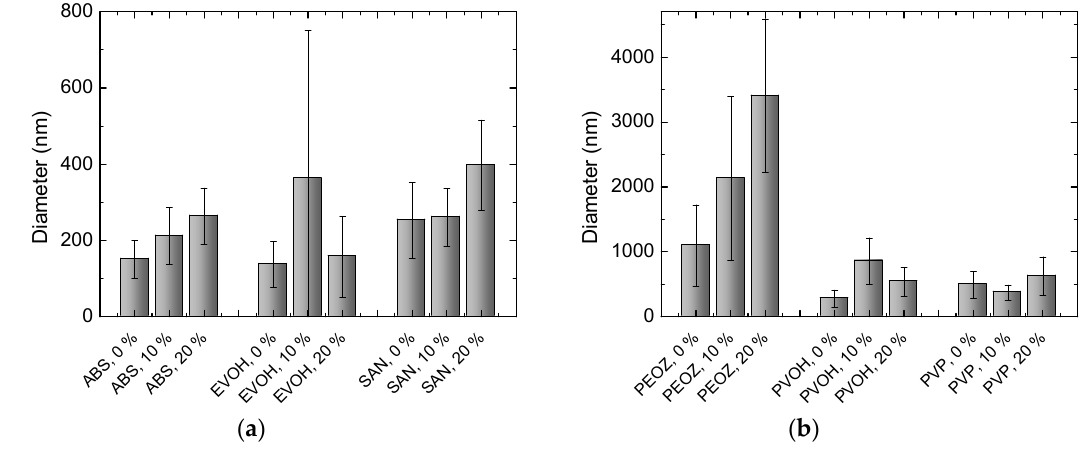
Figure 3. Average diameters of nanofibers electrospun ( a ) from different water-insoluble polymers; ( b ) from different water-soluble polymers.